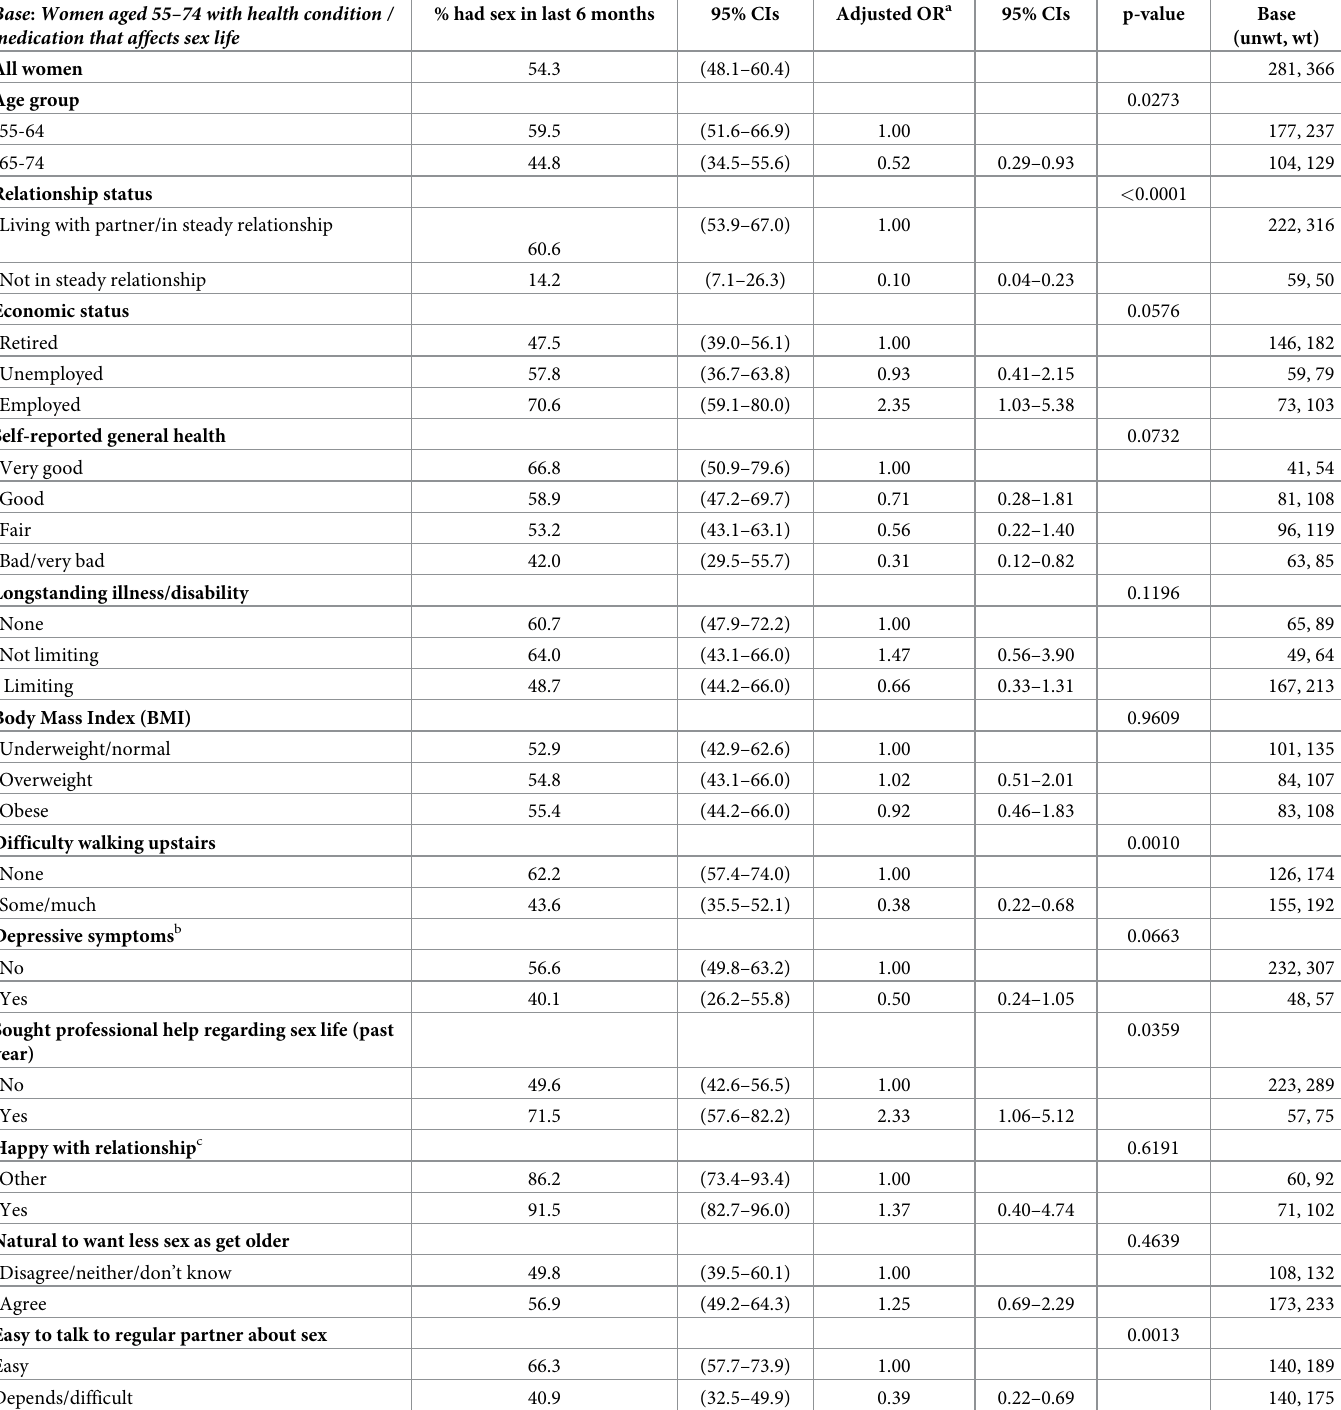
Table 4. Sexual activity in the last 6 months: